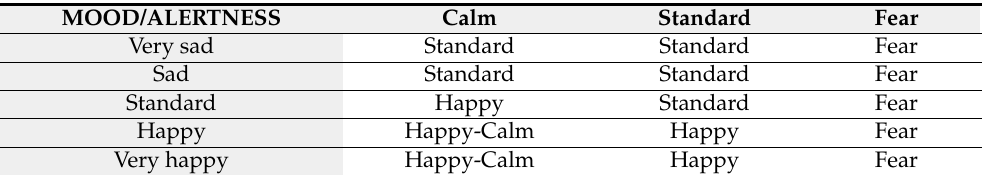
Table 10. Table of rules for MOOD/ALERTNESS facial expressions. The gray cells represent the different MOOD and ALERTNESS labels defined. MOOD/ALERTNESS Calm Standard Fear Very sad Standard Standard Fear Sad Standard Standard Fear